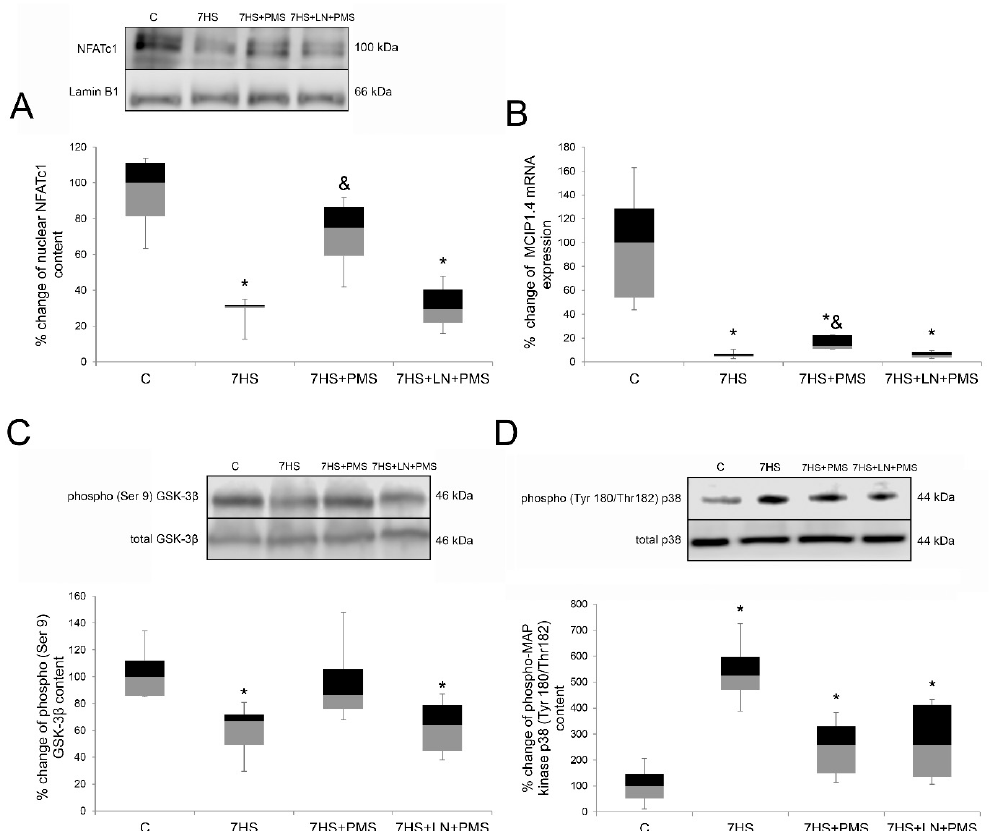
Figure 5. Western-blot analysis of NFATc1 nuclear content ( A ), phospho- GSK-3 β (Ser 9) content ( C ), phospho-p38(Tyr 180/Thr182) content ( D ) and expression level of MCIP1.4 mRNA ( B ) in rat soleus muscle in control group (C), 7-day hindlimb-suspended group (7HS), 7-day hindlimb suspended group with plantar mechanical stimulation (7HS + PMS), 7-day hindlimb suspended group with plantar mechanical stimulation+ L-NAME introduction (7HS + LN + PMS). Data are shown as % of the control group. *—significant difference from the control group. &—significant difference from 7HS group ( p < 0.05). Box plots show 25–75 percentiles and median values and the whiskers represent the minimum and the maximum; n = 8/group.